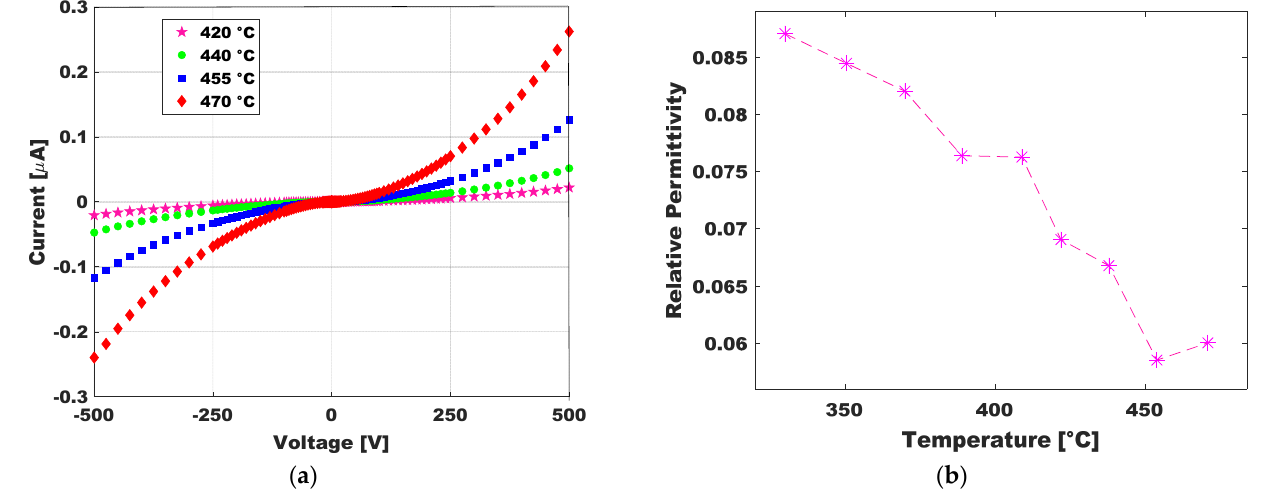
Figure A4. ( a ) Current of 1T-BD sample at the higher experimental temperatures. ( b ) Extraction of 1T-BD Relative Permittivity according to Temperature by using Equation (3).